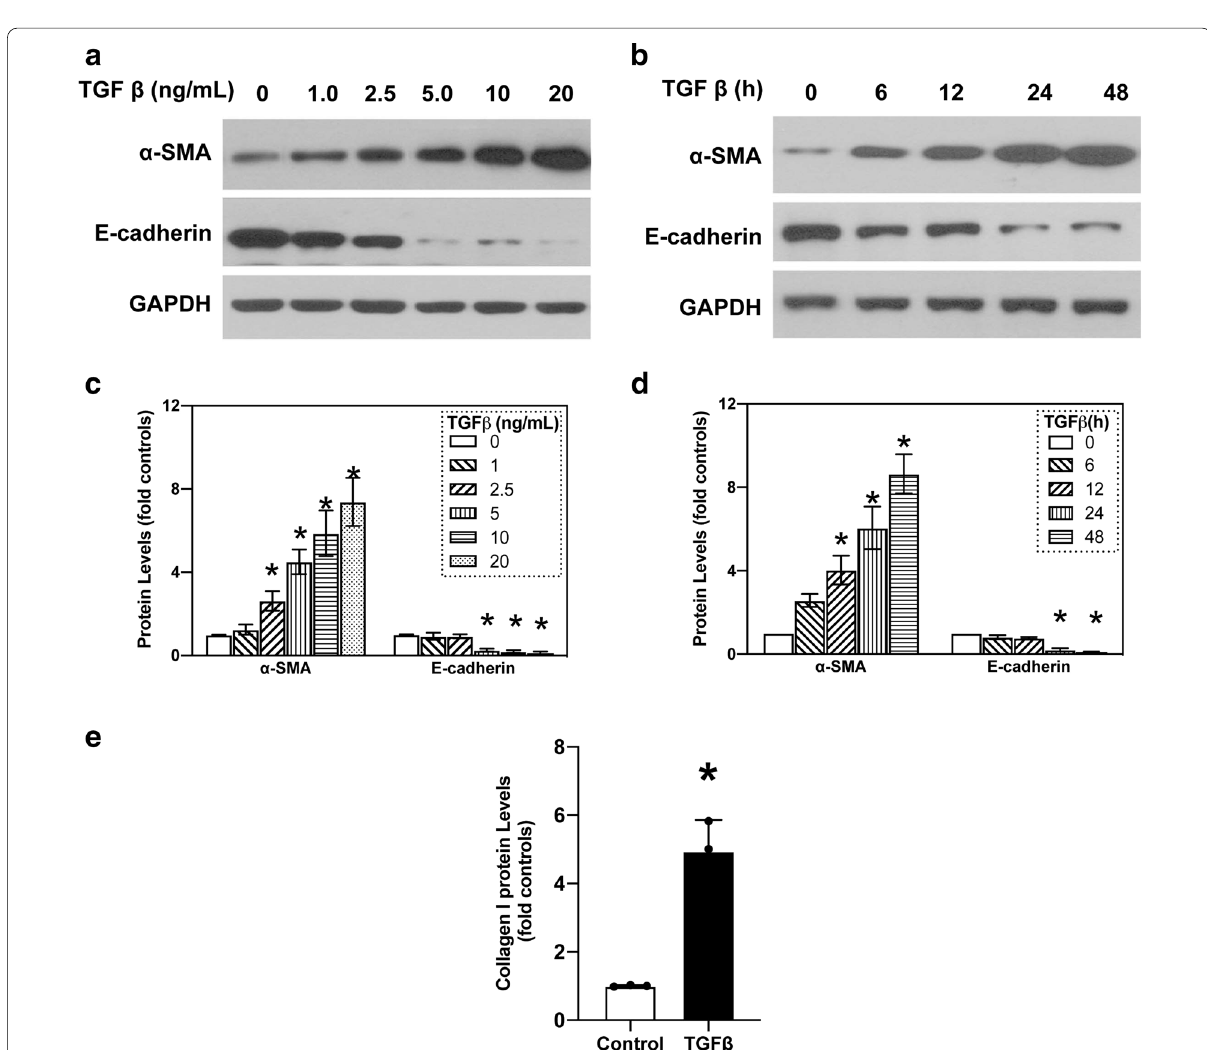
Fig. 1 TGF-β induced EMT and deposition of collagen-I in A549 cells. a A549 cells were exposed to TGF-β (0 α-SMA and E-cadherin were determined using western blotting, and quantification of western blots were calculated according to grey analysis. In agreement with the elevated expression of α-SMA, E-cadherin expression decreased in a dose-dependent manner, compared to non-stimulated cells. b Expression of α-SMA and E-cadherin in A549 cells treated with TGF-β (10 ng/mL) for 0, 6, 12, 24, and 48 h was assessed using western blotting. c , d Quantification of western blots were calculated according to analysis. e ELISA analysis of collagen-I levels in the supernatant of A549 treated with 10 ng/mL TGF-β for 24 h or controls. All data were from three separate experiments. Asterisk (*) denotes significant difference (P <